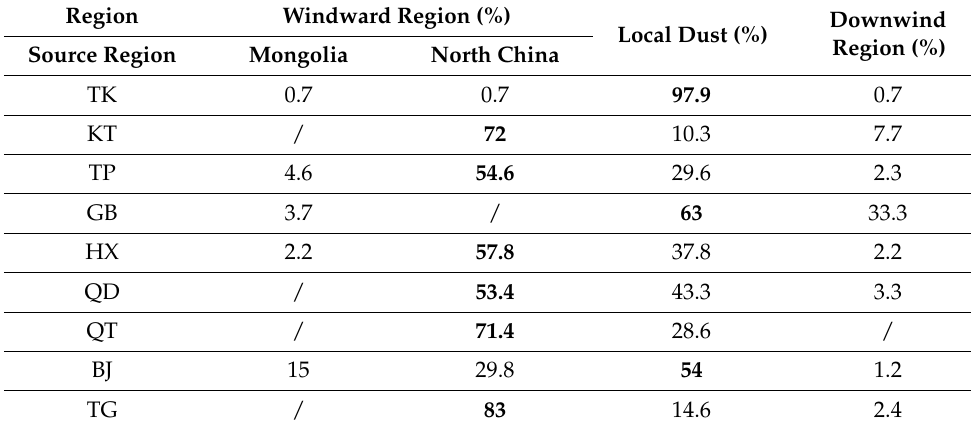
Table A2. Northern China DSN statistical result .